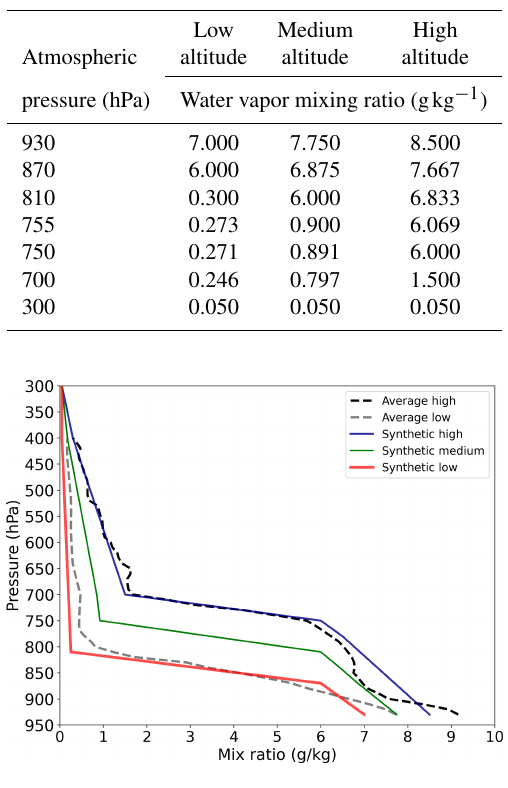
Figure 2. Simplified synthetic humidity profiles that describe the observed variability of winter radiosonde profiles. The high-altitude (blue) and low-altitude (red) synthetic profiles were based on aver- age profiles of radiosonde data from 2016–2019, shown as black and gray dashed curves. The medium-altitude synthetic profile (green) is an intermediate between the high- and low-altitude pro-